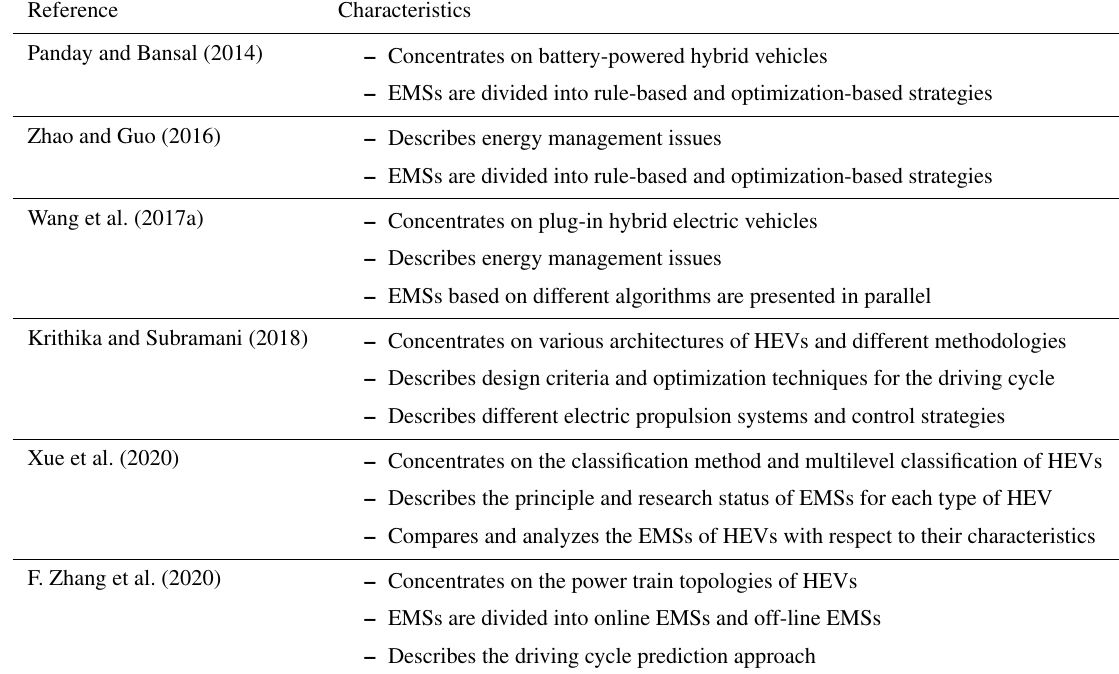
Table 1. Summary of exemplary works reviewing energy management strategies